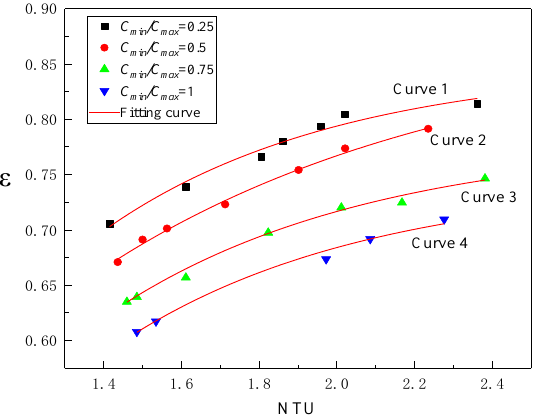
Figure 13. Variation of heat transfer rate and h w .